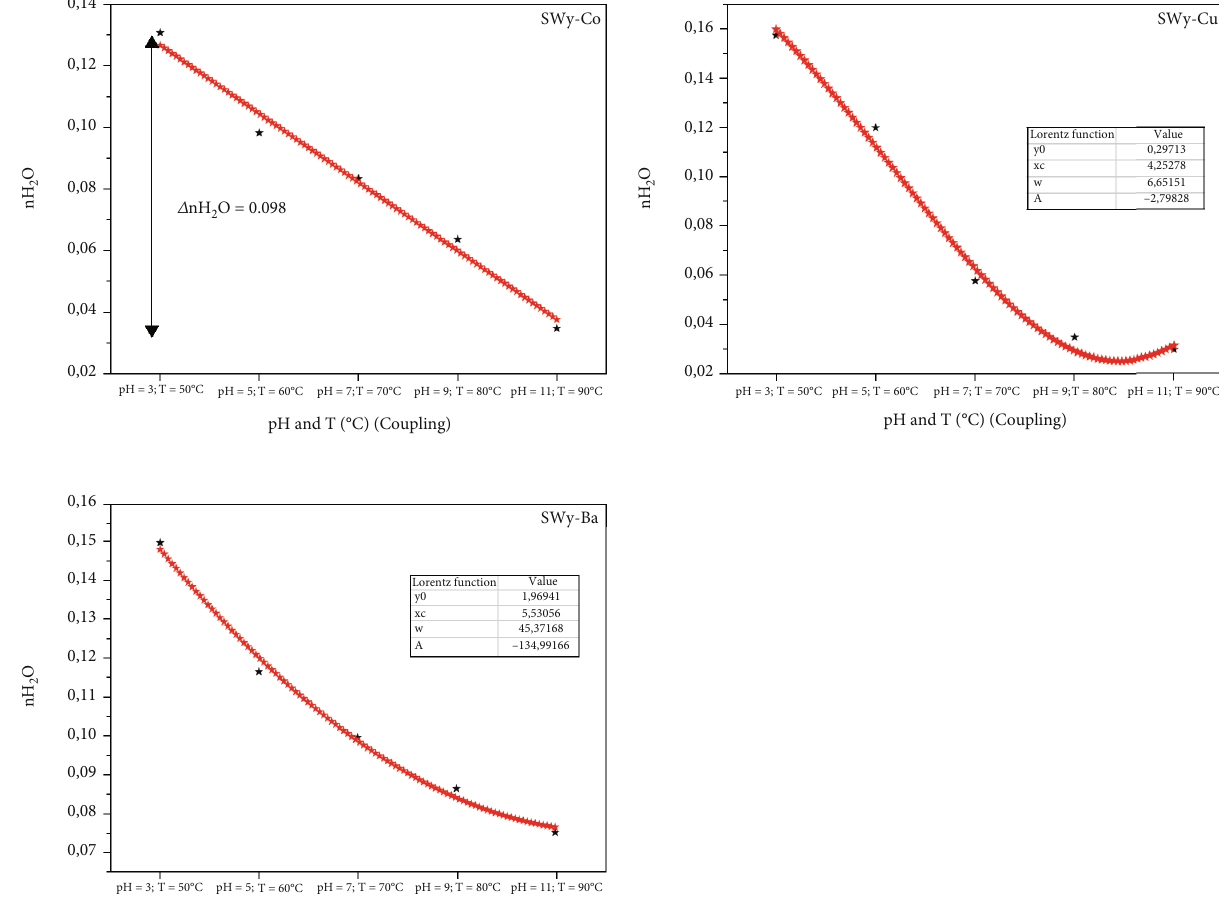
Figure 9: nH O abundance fl uctuation as a function of stress strength for SWy-Co, SWy-Cu, and SWy-Ba samples (black scatter). Red 2 scatter: the used linear and Lorentz fi t function,